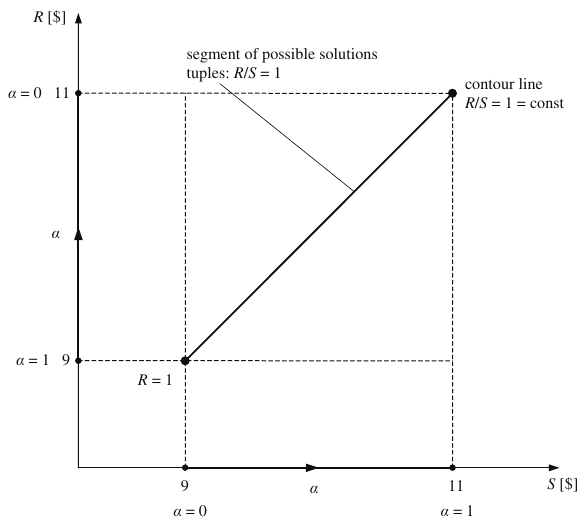
Fig. 11. Illustration of the solution of the same IPVs di- vision problem from Example 4. Variables V and V sp are completely dependent.